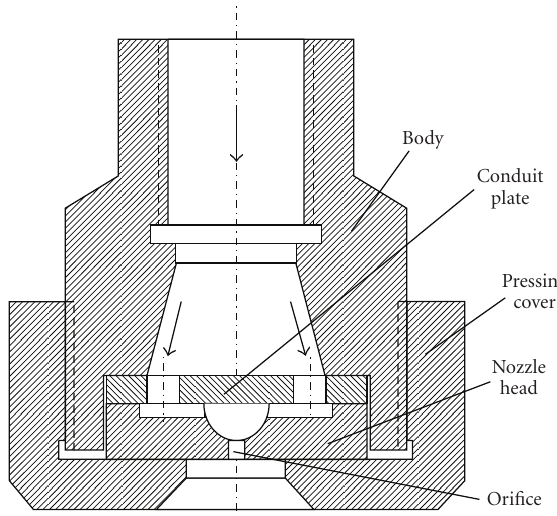
Figure 4: The eddy pressure nozzle.